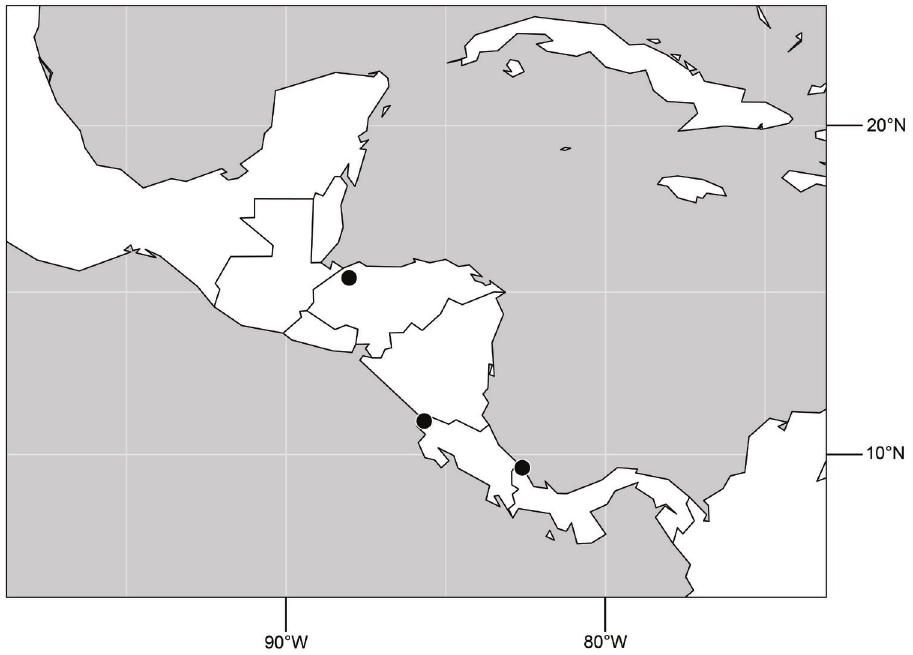
Figure 35. Distribution of Hydrochasma rictum sp.